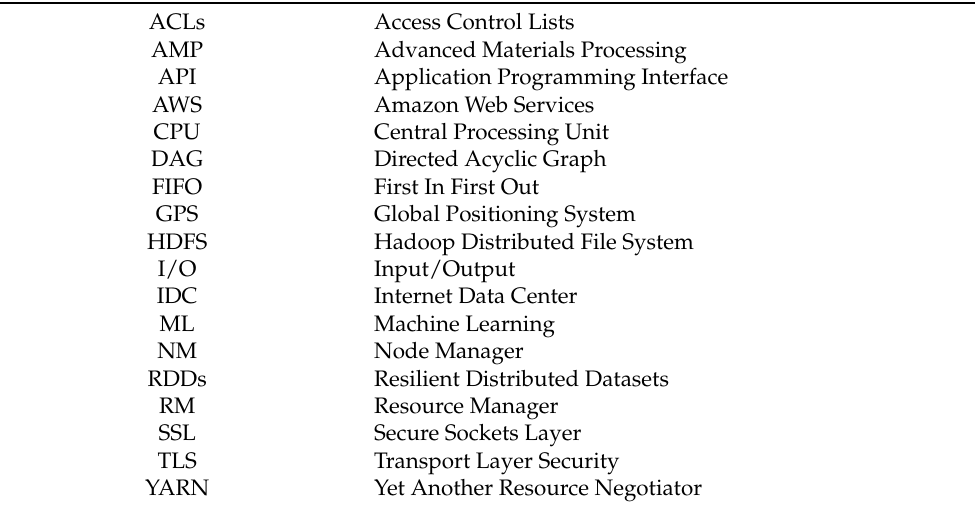
Table 1. List of acronyms used in this